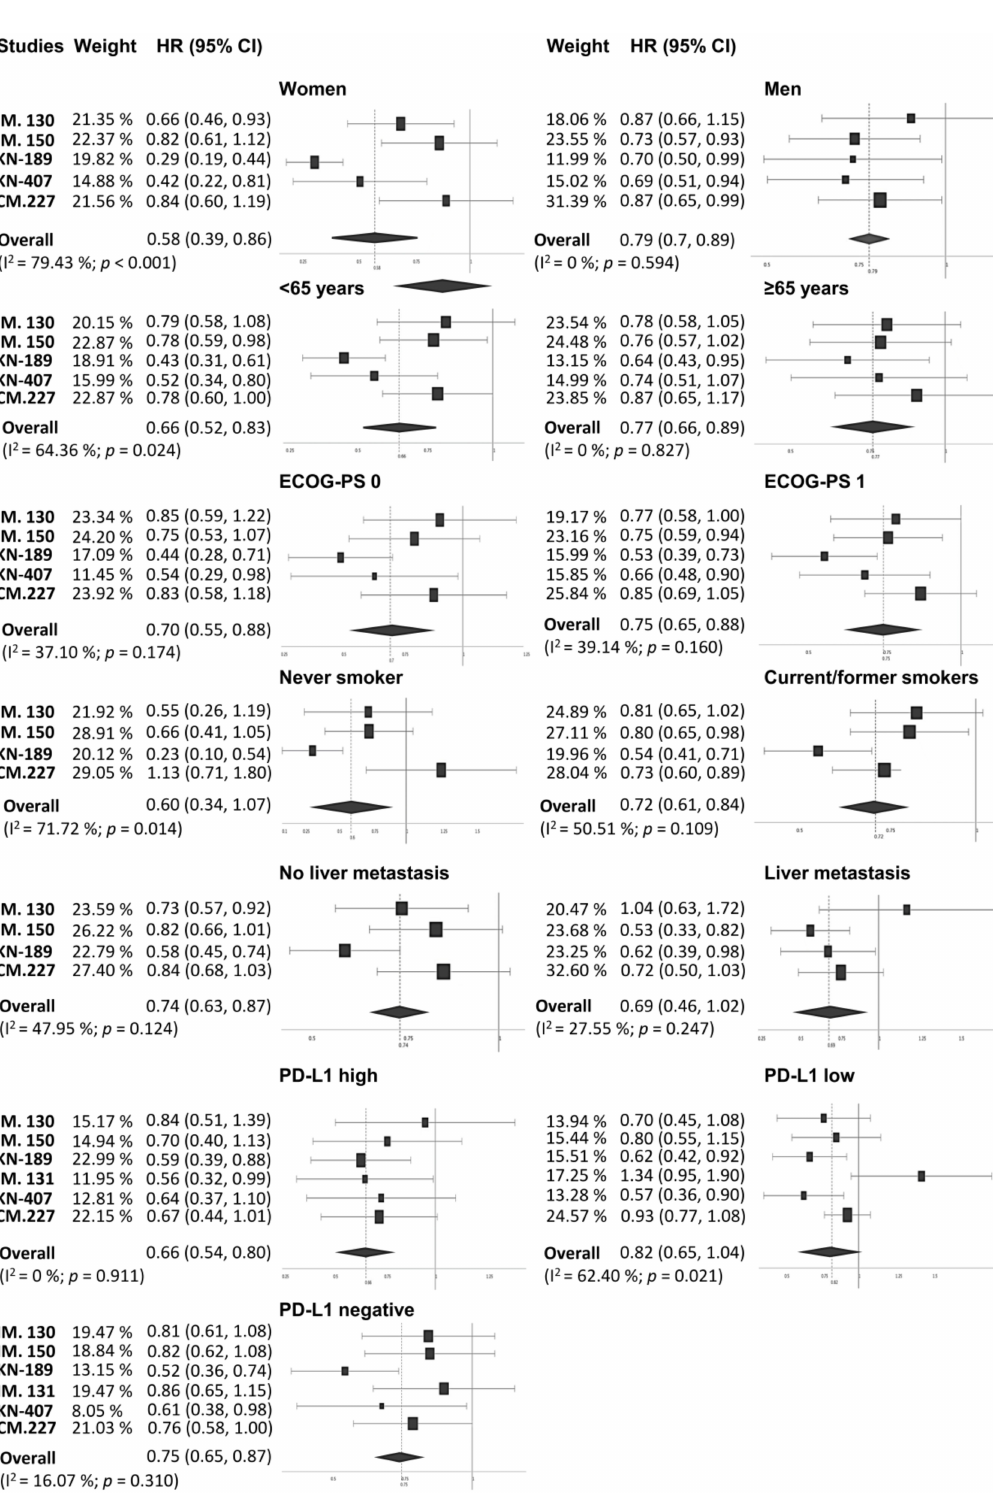
Figure 5. Forest plot of hazard ratios for overall survival (OS) in the di ff erent patient subgroups. CI, confidence interval; HR, hazard ratio; ECOG-PS, Eastern Cooperative Oncology Group performance status; IM., IMpower; KN, KEYNOTE; CM.,